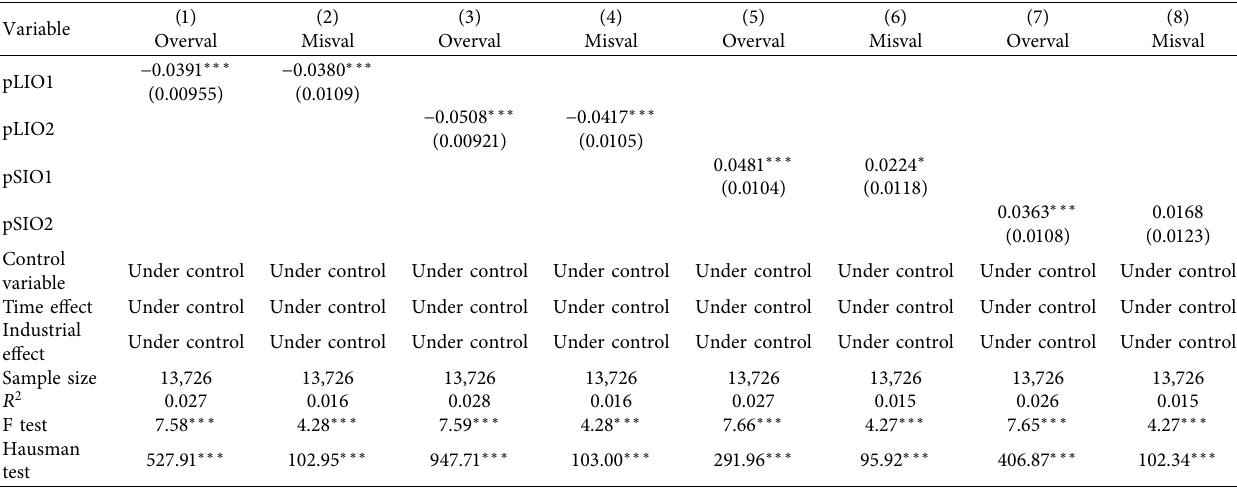
Table 3: Long-term and short-term institutional investors and stock mispricing.